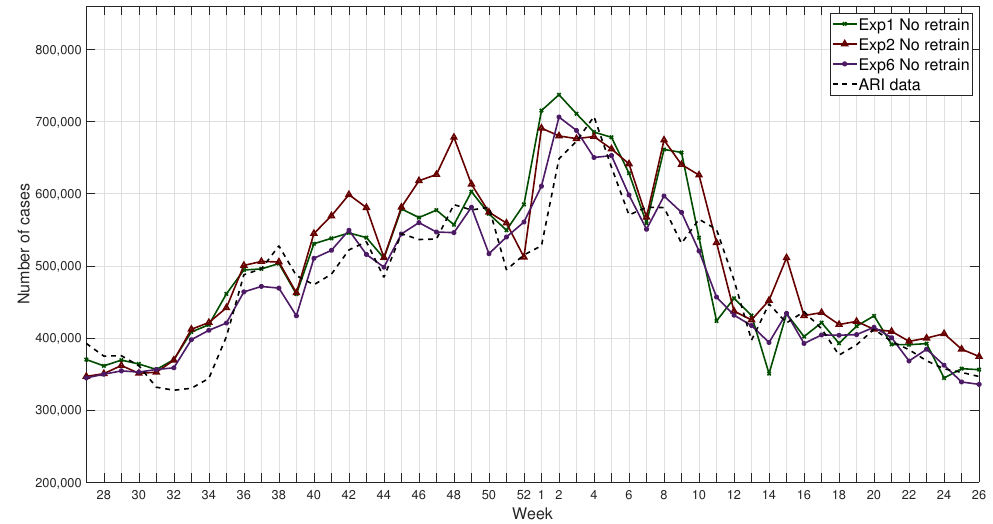
Figure 10. Example of results for networks without retraining for the 2017–2018 winter season compared with ARI